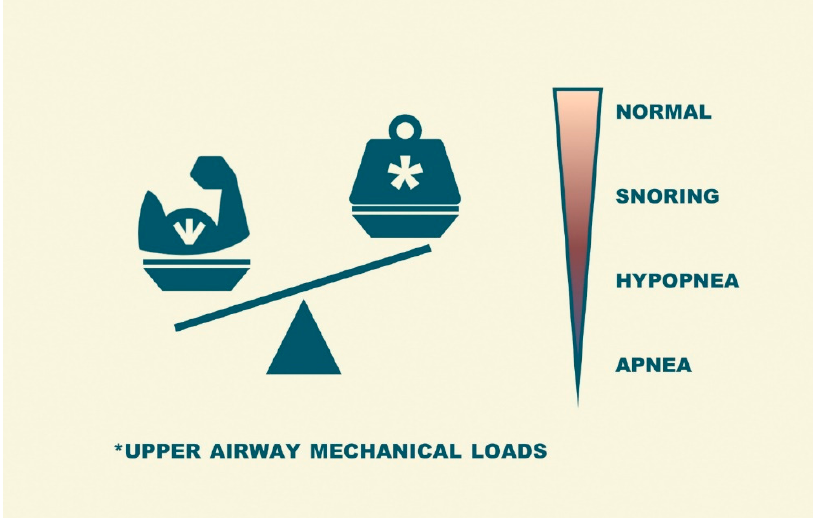
Figure 1. Representation of the imbalance produced during sleep between the loads on the upper airway and the function upper airway dilator muscles in obstructive sleep apnea (OSA) patients.